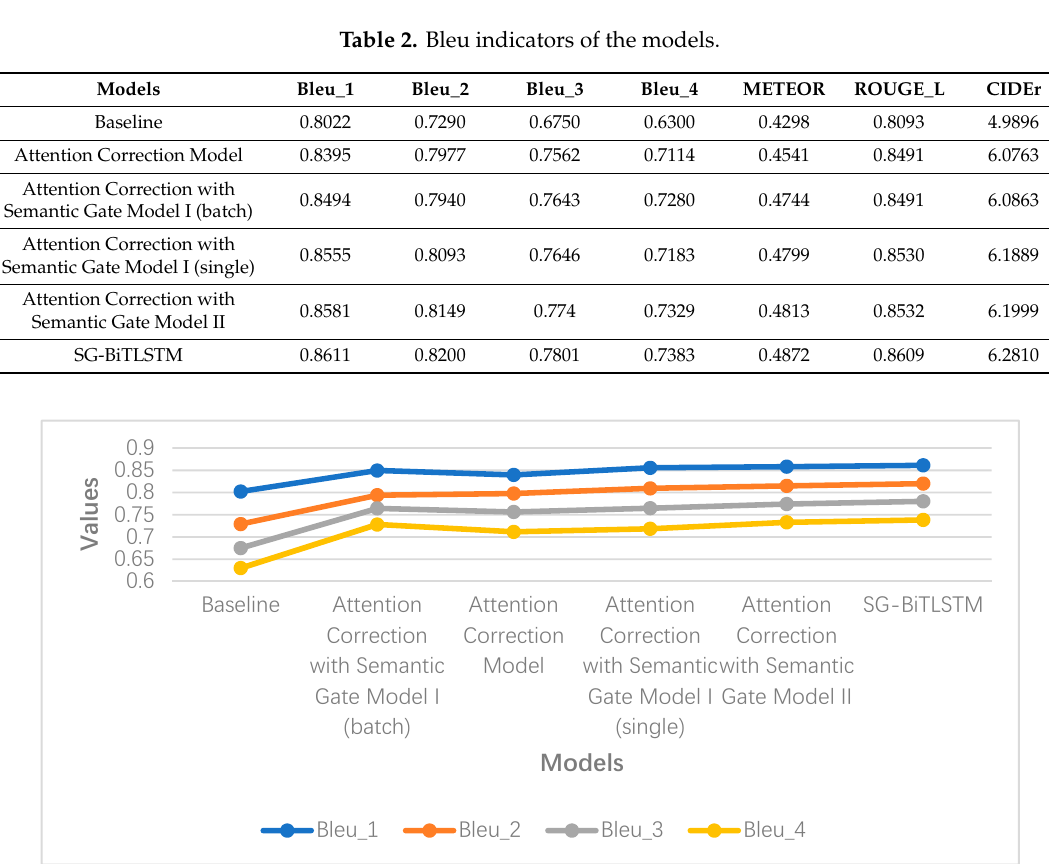
Table 2. Bleu indicators of the models.